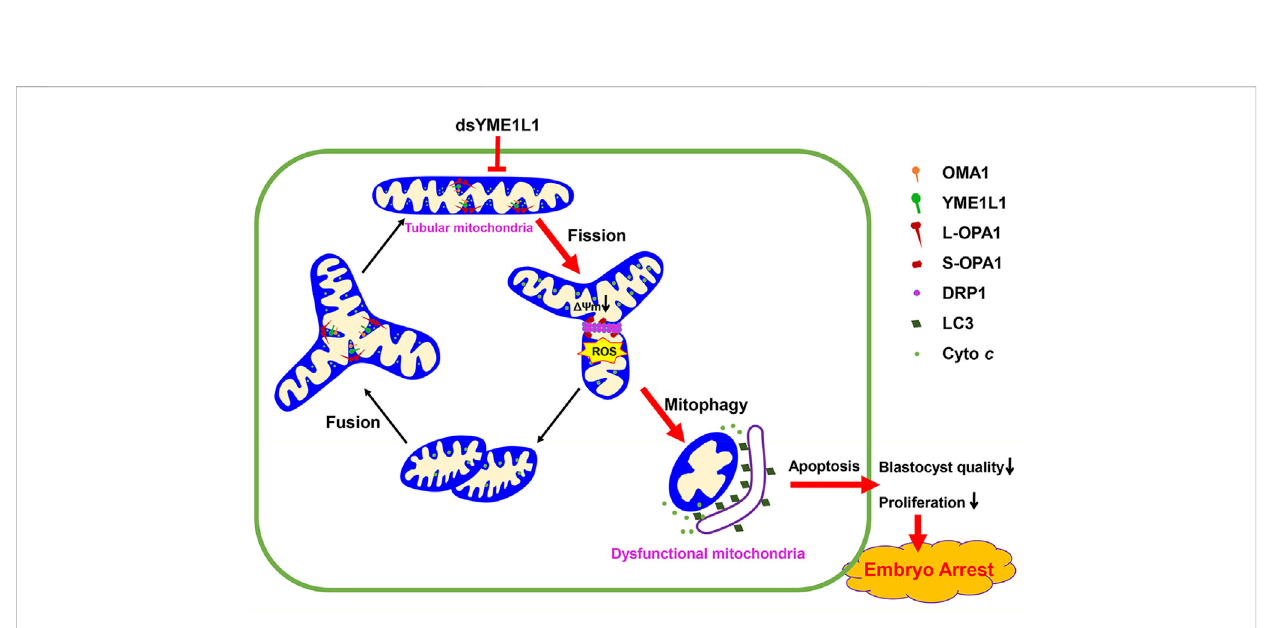
The balance ofmitochondrial fusion and fi ssion maintainsfunctional morphology of mitochondria to support the porcine embryonic development. However, knock-down of YME1L1 during porcine embryo development results in mitochondrial dysfunction and fi ssion which causes reduction of mitochondrial membrane potential and increased mitochondrial ROS generation, leading to mitochondrial fragmentation and